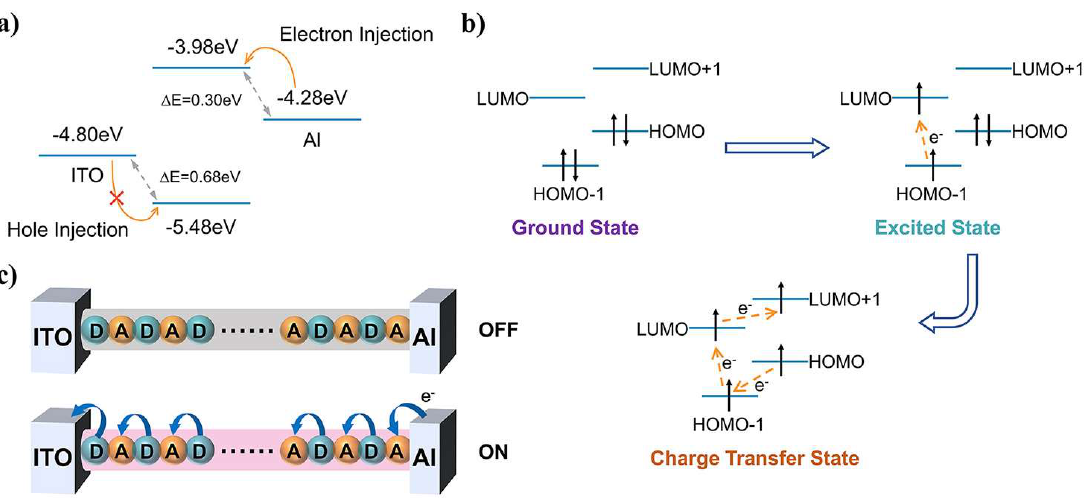
Figure 4. ( a ) Schematic diagram of the charge injection processes in the memory device. ( b ) Plausible electronic transitions in the excitation of PDHT- g -MWNTs. ( c ) The proposed charge transfer processes in Al/PDHT- g -MWNTs/ITO.